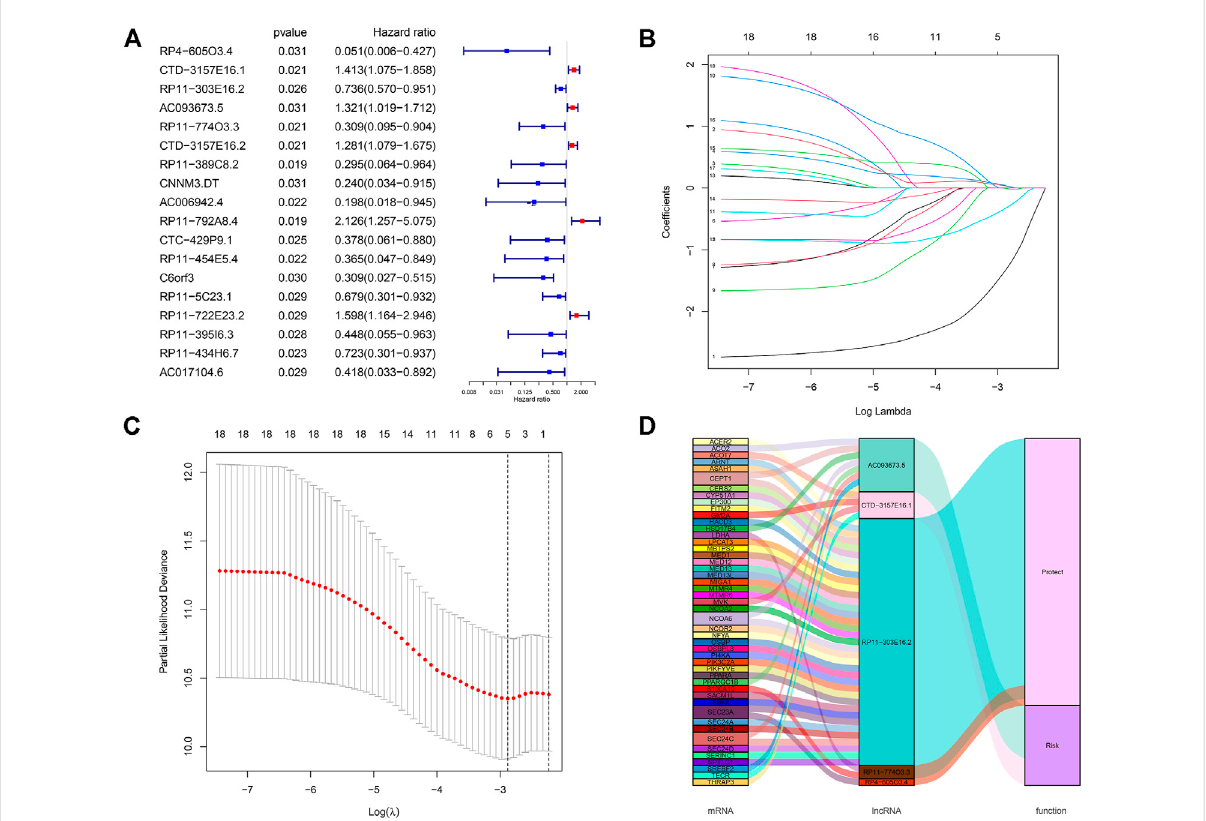
FIGURE 2 Screening of lipid metabolism-related lncRNAs with signi fi cant prognostic value in CC. (A) Forest plot illustrating the HR and p -value of 18 lipid metabolism-related lncRNAs by univariate Cox proportional hazards analysis; (B,C) LASSO Cox regression of the selected lncRNAs to calculate the minimum criteria (B) and coef fi cients (C) ; (D) Alluvial map showing the relation between lipid metabolism-related mRNA and lncRNA, and their corresponding